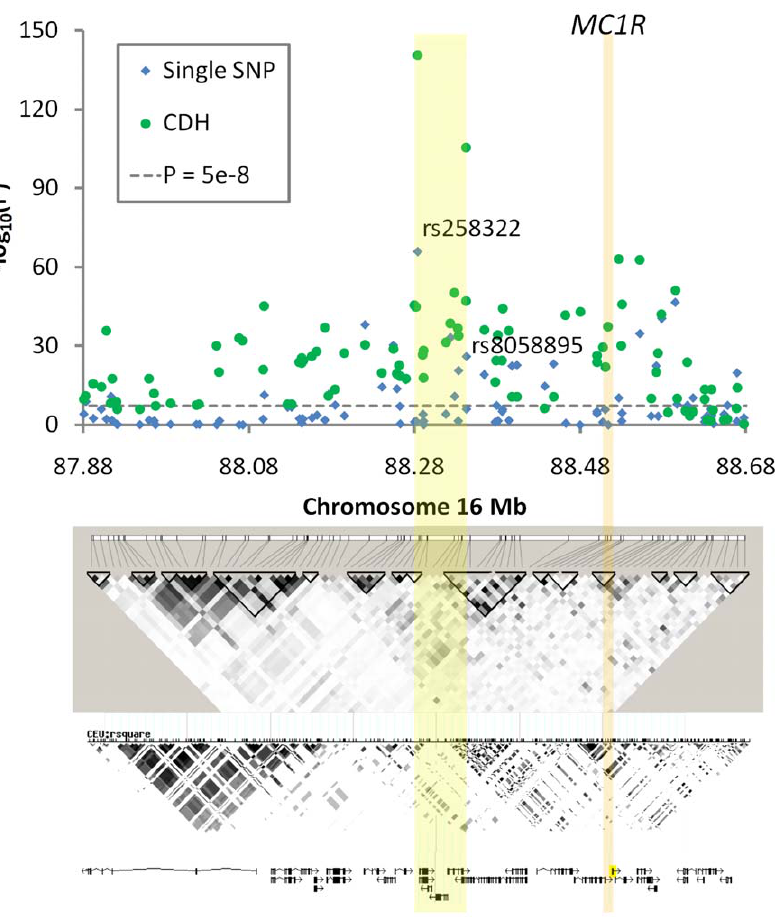
Figure 5. Association between SNPs at MC1R and the red hair color in the Rotterdam Study. The -log 10 (P) values for association with red hair color were plotted for each genotyped SNP according to its chromosomal position (blue dots) and for the CDH test in each sliding window consisting of 100 SNPs (green dots represent the left-most SNP). The LD patterns in the Rotterdam Study population and in the HapMap CEU samples (release 27) and the known genes in the region were aligned bellow according to the physical position of the SNPs (genome-build version 36.3). The orange bar indicates the physical position of the MC1R gene. The yellow bar indicates the region between two SNPs based on which the most significant P value of the CDH test was obtained (the left-most SNP rs258322 and the right-most SNP rs8058895).